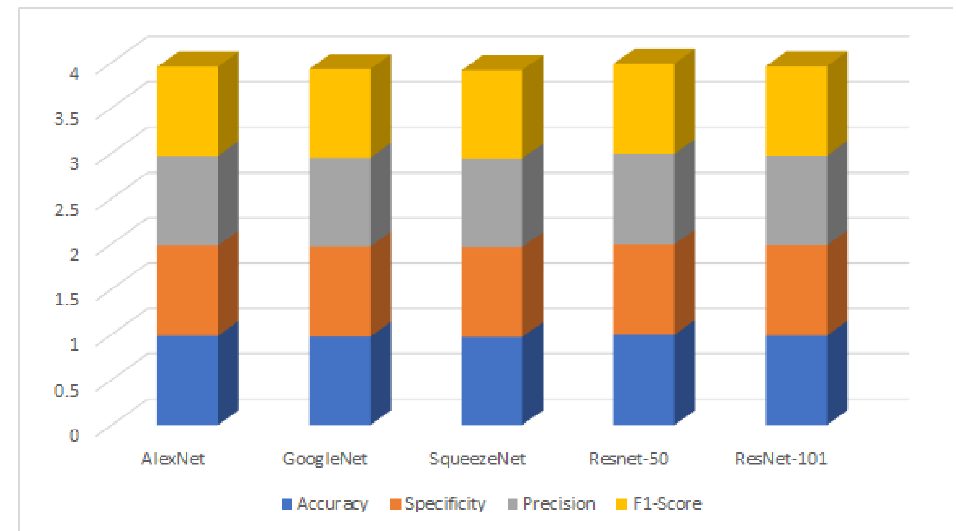
Figure 4. Guava disease classification result visualization.